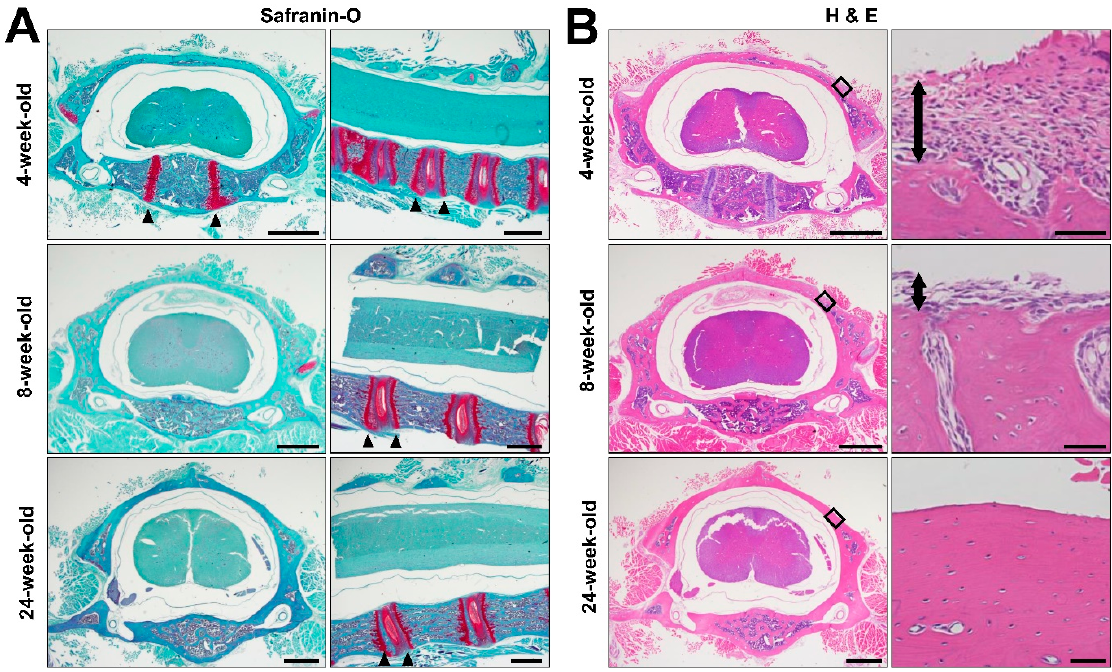
Figure 4. Histology of C5 Spinal segments. ( A ) Coronal and sagittal images of Safranin O-stained sections of the C5 spine in a female rat at 4, 8, and 24 week old. Arrow head indicates the primary ossification center in the vertebral body of 4-week-old subject. Epiphyseal line next to the vertebral endplate was present in all examined subjects as indicated by arrow heads. Scale bars, 1 mm. ( B ) Low and high magnification coronal images of Hematoxylin and Eosin (H&E) stained sections of C5 spinal segment in female rats at 4, 8, and 24 weeks of age. Right images are high magnification views of the boxed areas in left images. The thickness of the periosteum on the surface of the lamina decreases over time, as indicated by two-headed arrows. It finally disappeared at 24 weeks of age. Scale bars, 1 mm.